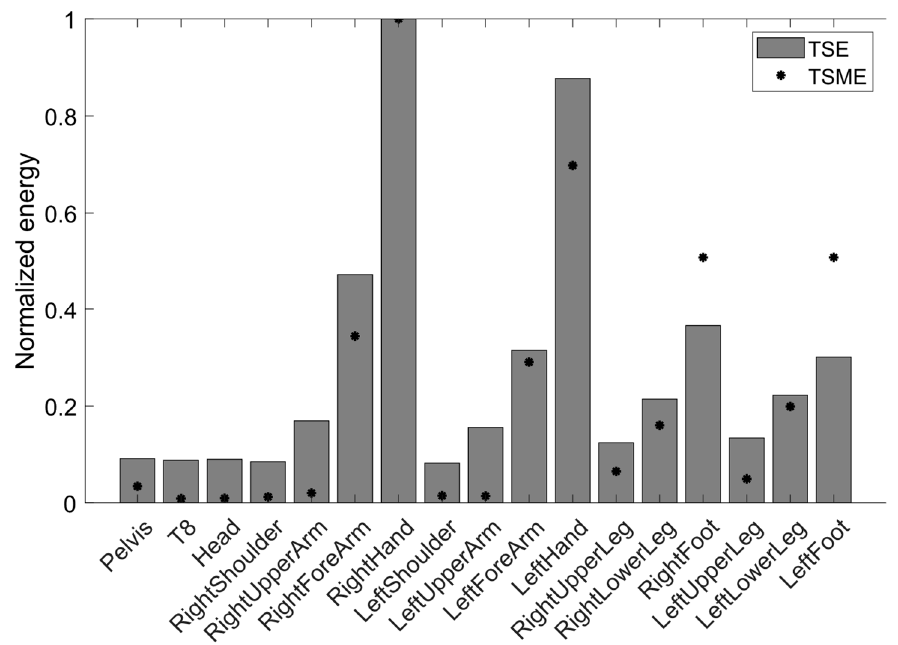
Figure 13. Normalized energy of acceleration data (TSE) and simulated harvester model (TSME), at di ff erent body locations.